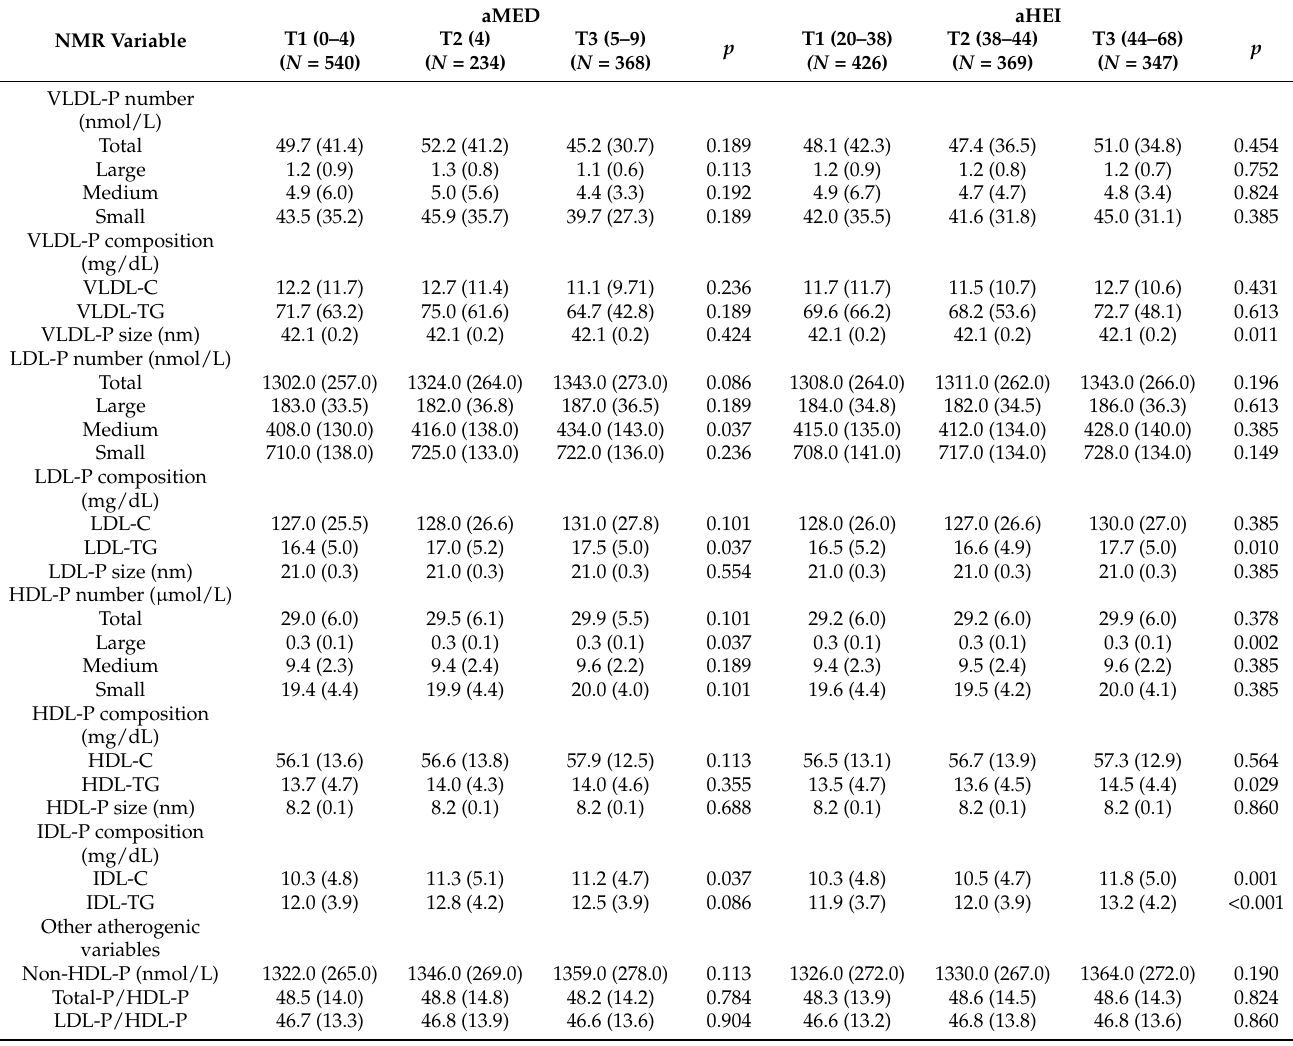
Table 2. Nuclear magnetic resonance -assessed advanced lipoprotein profile according to adherence to the diet assessed using dietary quality